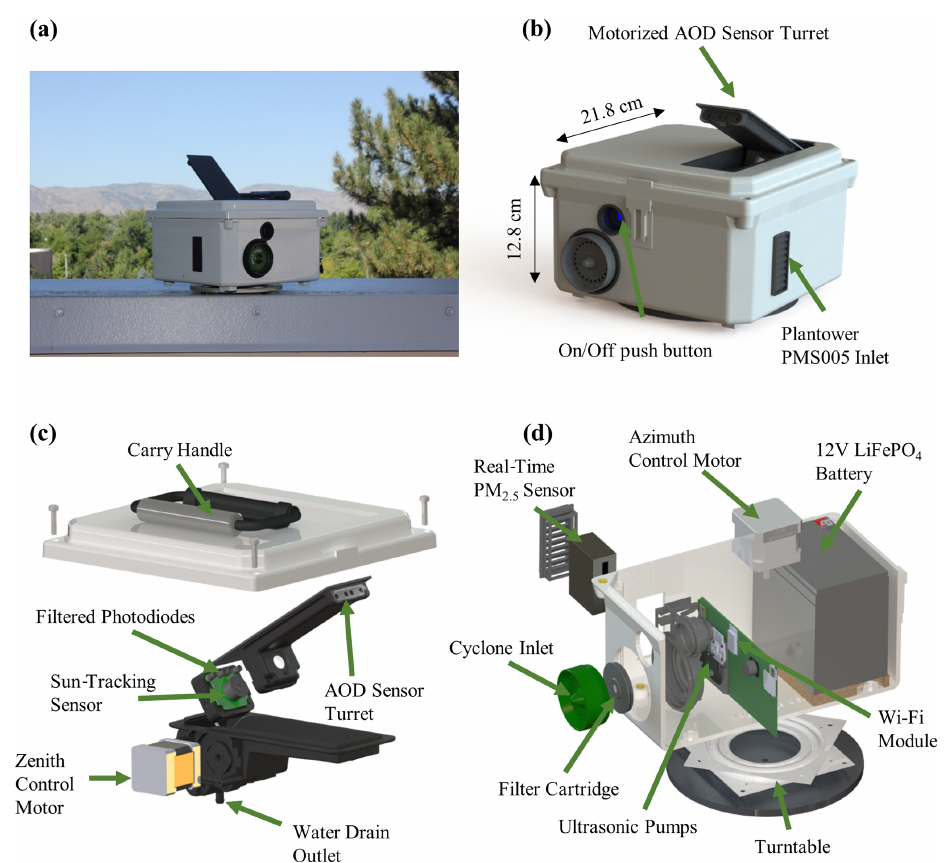
Figure 1. Images detailing the external and internal AMODv2 design and hardware: (a) photograph of the AMODv2 sampling outdoors; (b) external computer-animated rendering of AMODv2 features and dimensions; (c) computer-generated exploded view of the AOD mea- surement subsystem; (d) computer-generated exploded section view of the PM 2 . 5 sampling, wireless data transfer, and power